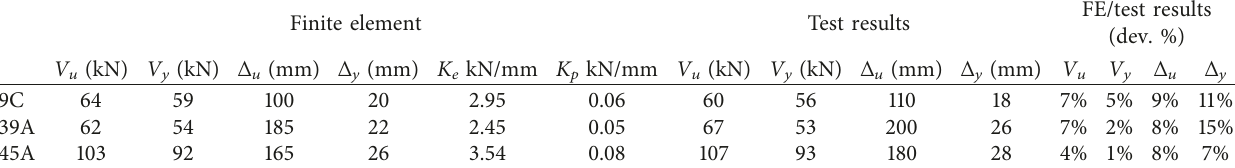
Table 3: Results summary.